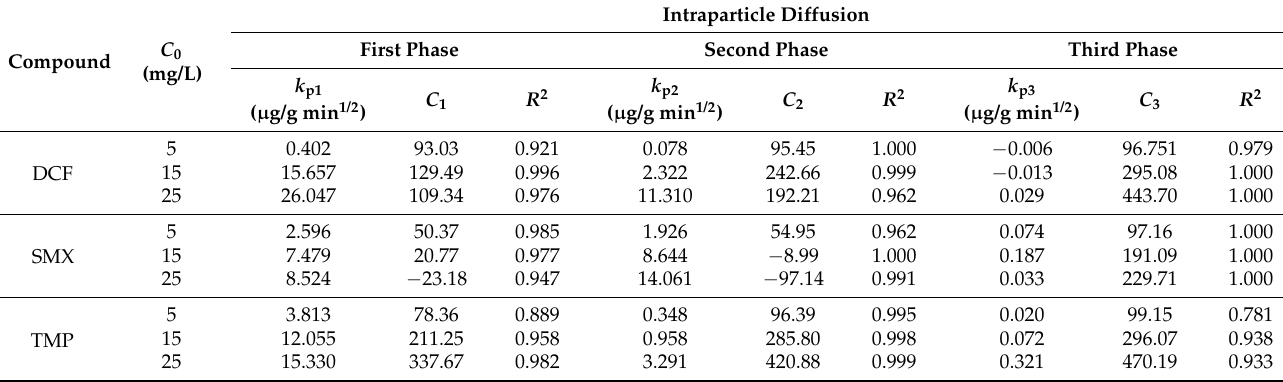
Table 2. Intraparticle diffusion model constants and correlation coefficients for DCF, SMX and TMP sorption at different initial concentrations ( C 0 ), together with the respective regression coefficients ( R 2 ). The PAC concentration used for the model is 1